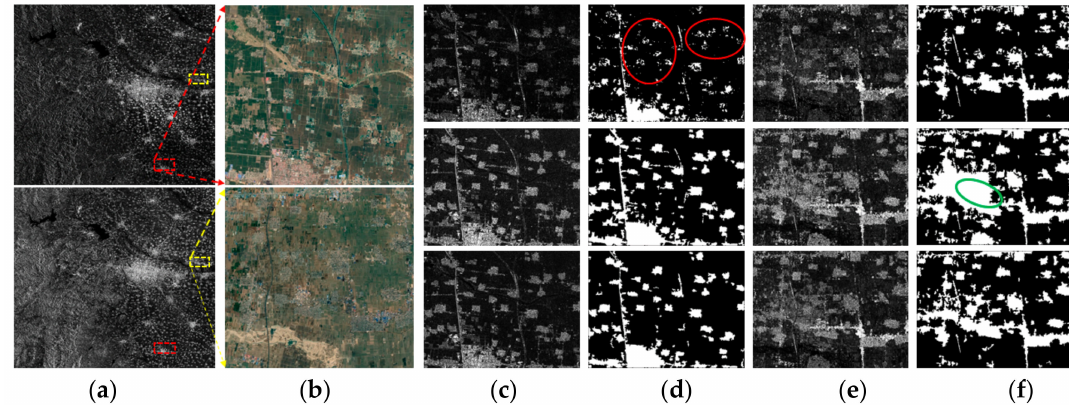
Figure 3. Comparison of BAs extraction in Shijiazhuang using different image channels. ( a ) VV and VH images from top to bottom; ( b ) the optical images from Google earth corresponding to the red and yellow rectangles in ( a ); ( c ) VV, VH, and averaged image of two channels corresponding to the red ROI in ( a ); ( d ) corresponding BAs extraction results of ( c ); ( e ) VV, VH and averaged image of two channels corresponding to the yellow ROI in ( a ); ( f ) corresponding BAs of ( e ). White: BAs, Black: other land